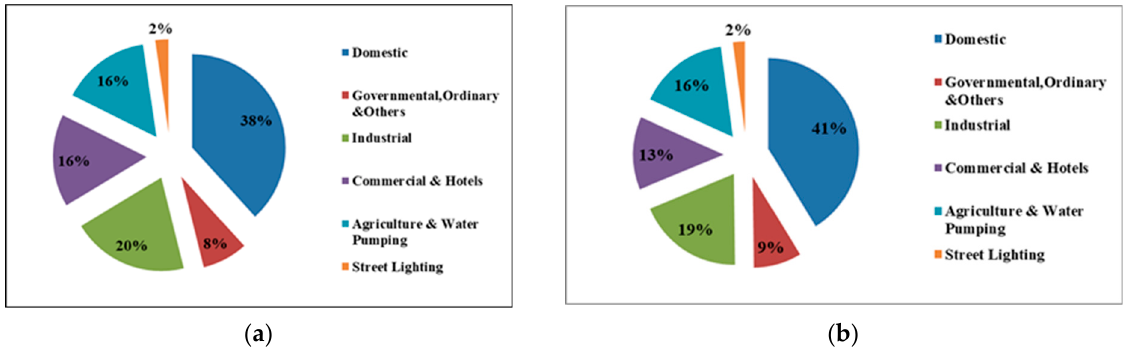
Figure 7. Electricity consumption by sector in ( a ) 2019 and ( b ) 2020.